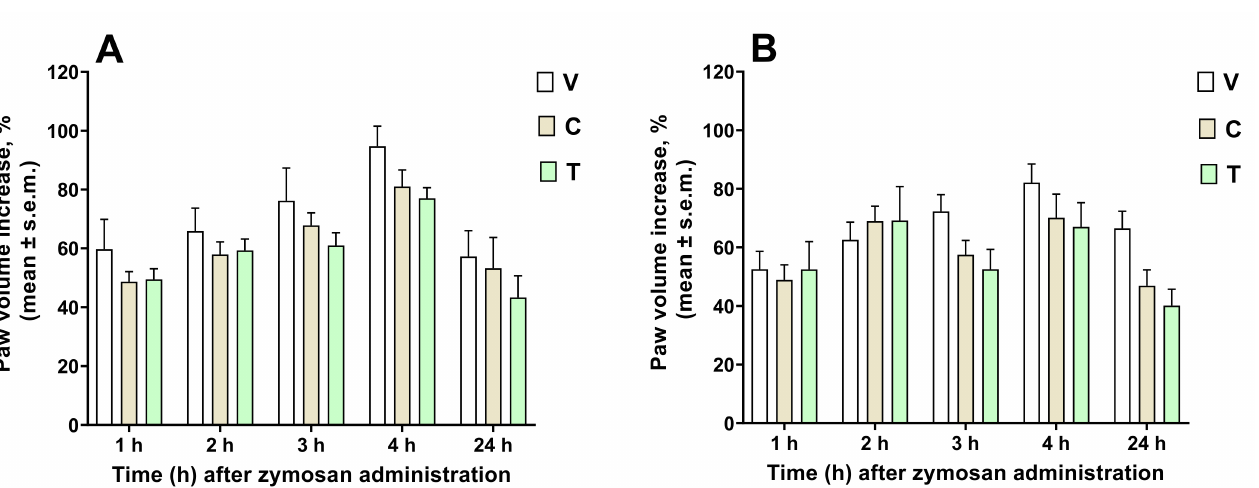
Figure 3. Effects induced by Cannellino Bio (C) and Tondino del Tavo (T) decoction extracts adminis- tered s.c. into the mice hind paw at the dose of 100 µ g/20 µ L paw, 15 min before ( A ) or 150 min after ( B ) zymosan (2.5% w / v in saline, 20 µ L/paw) administration in the same paw. Statistical analysis was performed by using two-way ANOVA followed by Dunnett’s multiple comparisons test. C and T induced a reduction in zymosan-induced oedema, but this effect did not reach statistical significance both in ( A , B ). N =